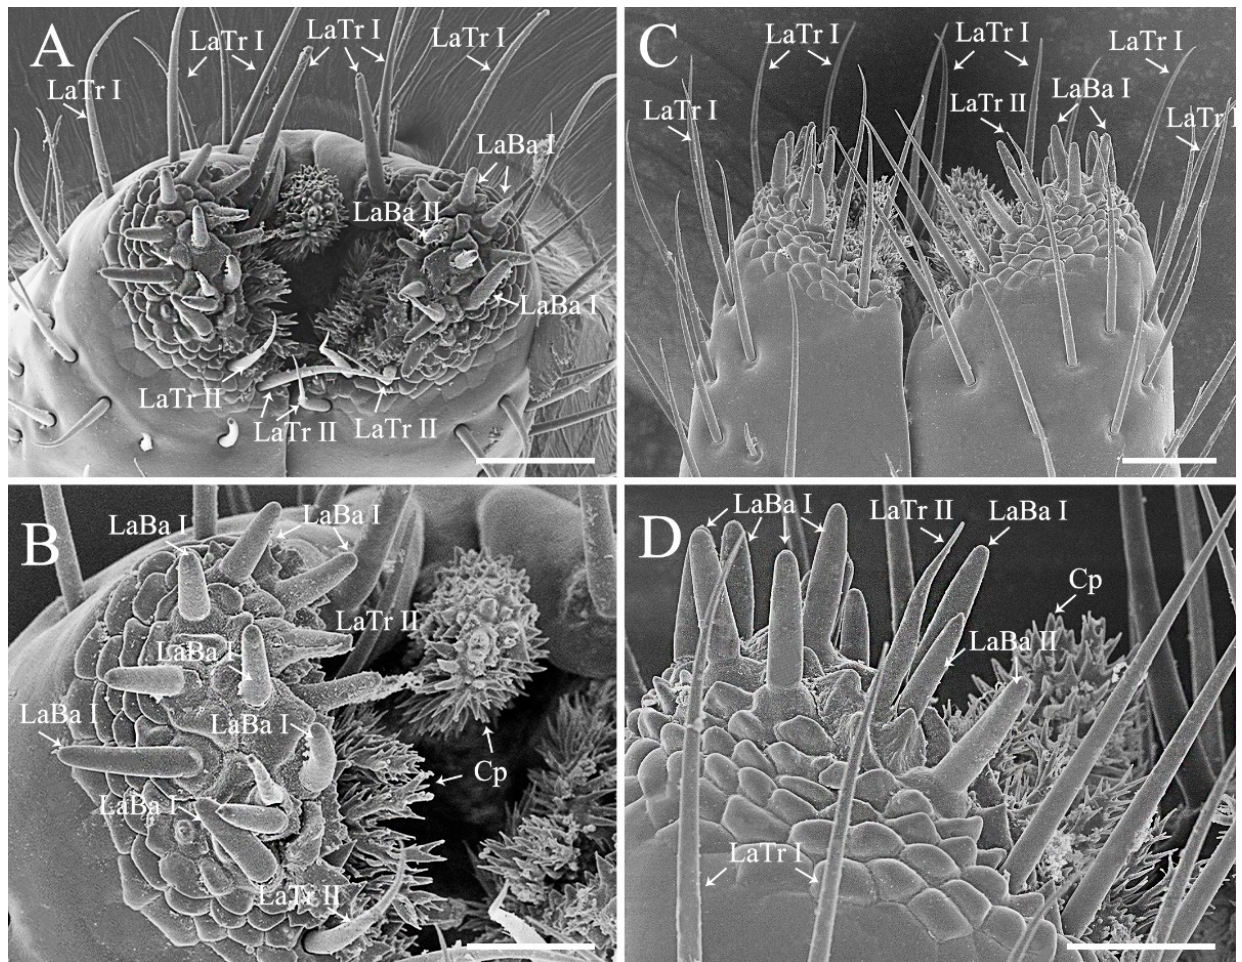
Figure 6. Labial apex of Halyomorpha halys ( A , B ) and Plautia crossota ( C , D ), showing labial sensilla and cuticular projections. Scale bars: ( A , C ) 25 μ m; ( B , D ) 15 μ m. Abbreviations: Cp, cuticular projection; LaBa I–II, labial sensilla basiconica I–II; and LaTr I–II, labial sensilla trichodea I–II.